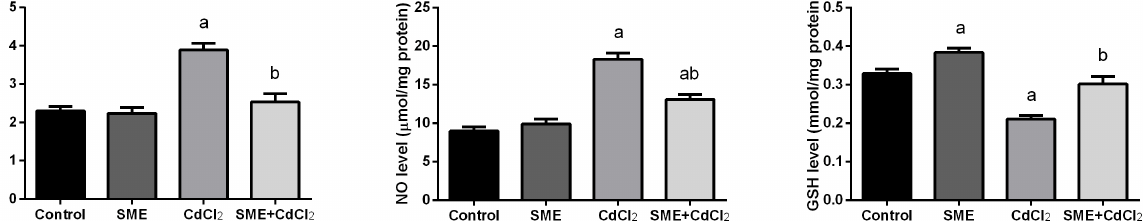
Figure 2. The oxidative indices (malondialdehyde (MDA), nitric oxide, and glutathione) in the renal tissue of adult (3.5 mg/kg) and/or SME (100 mg/kg). Values are presented as mean ± SD (n = 10). male rats treated with CdCl 2 a p < 0.05 compared to the control group; b p < 0.05 compared to the CdCl